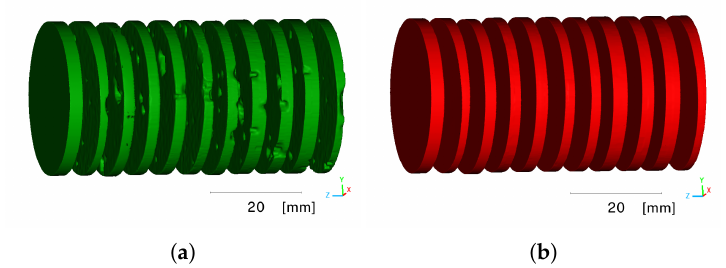
Figure 10. The real 3D model of the sample with voids ( a ) and the standard 3D model without voids ( b